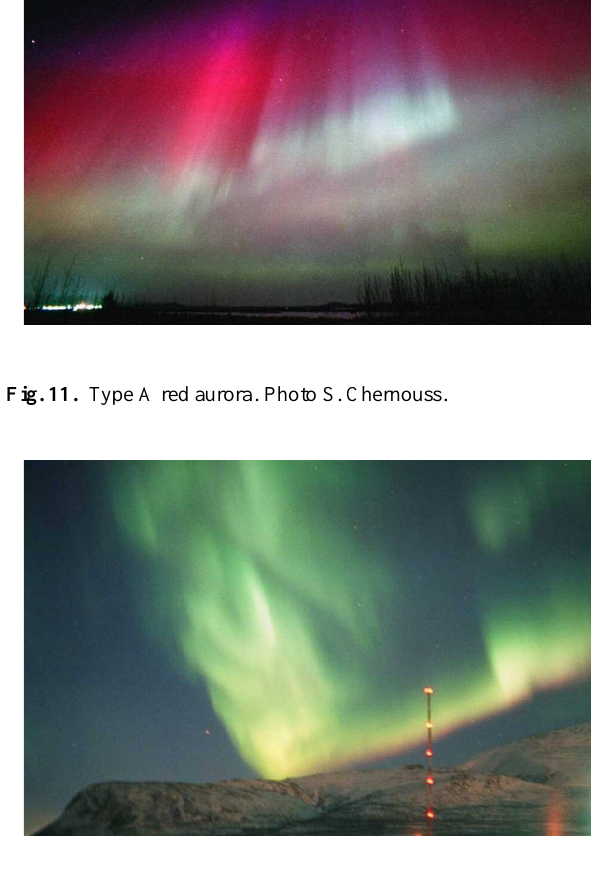
Fig. 10. Normalized occurrence of aurora as a function of magnetic local time. The heavy lines mark observations by Sykora (S) and the thin lines observations by Westman (W). The top panel shows observations north of the stations, the middle panel observations in zenith, and the bottom panel observations to the south.